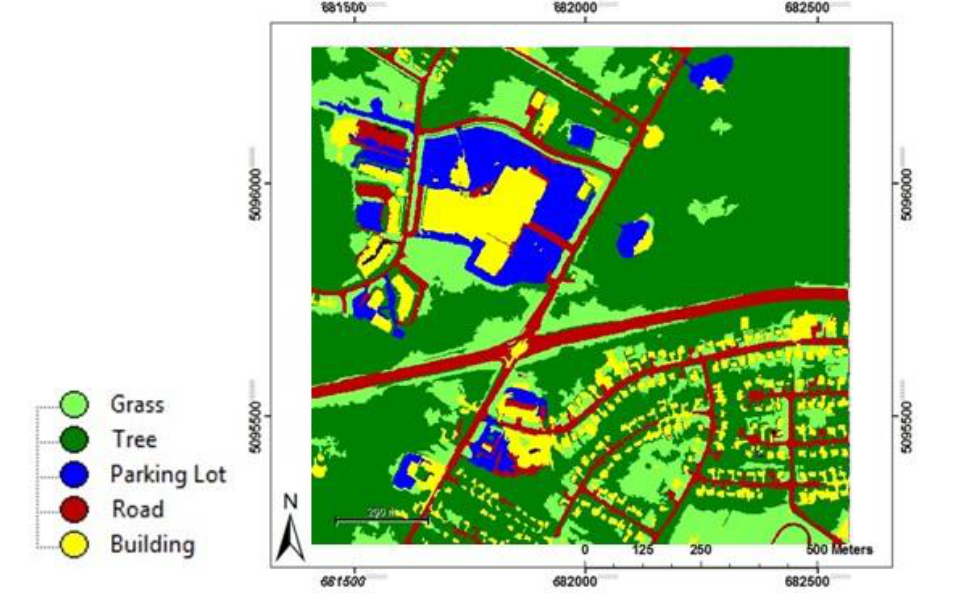
Figure 5. Hierarchical object-based classification results of the QB Pilot image.